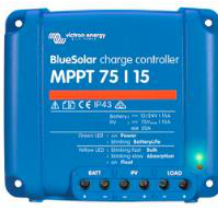
Figure 4. Victron BlueSolar MPPT Charge Controller.